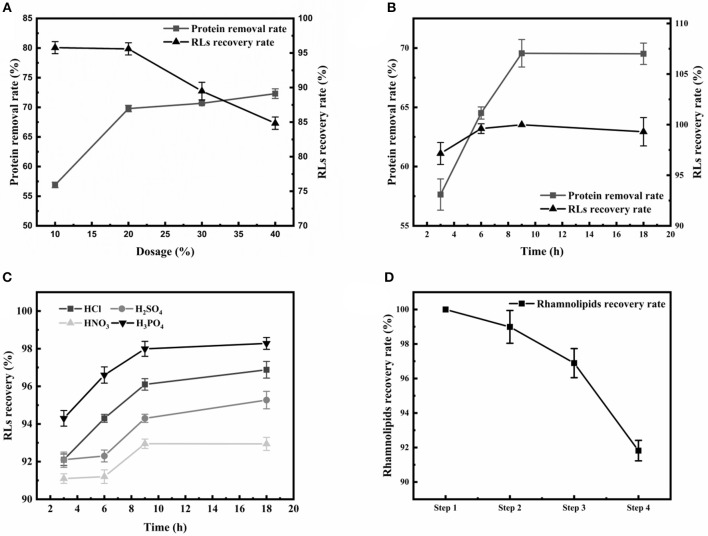
Optimization of the crude RLs separation process. (A) The effects of different ethanol concentrations on the rhamnolipid recovery rate and protein removal rate; (B) The effects of different durations of ethanol precipitation on the rhamnolipid recovery rate and protein removal rate; (C) The effects of different acids on the RLs recovery rate. (D) Summary of purification of rhamnolipids from the fermentation broth. The rhamnolipid sample concentration was 10 g/L. The rhamnolipid recovery rate is calculated by comparing the pre- and post-treatment concentrations.